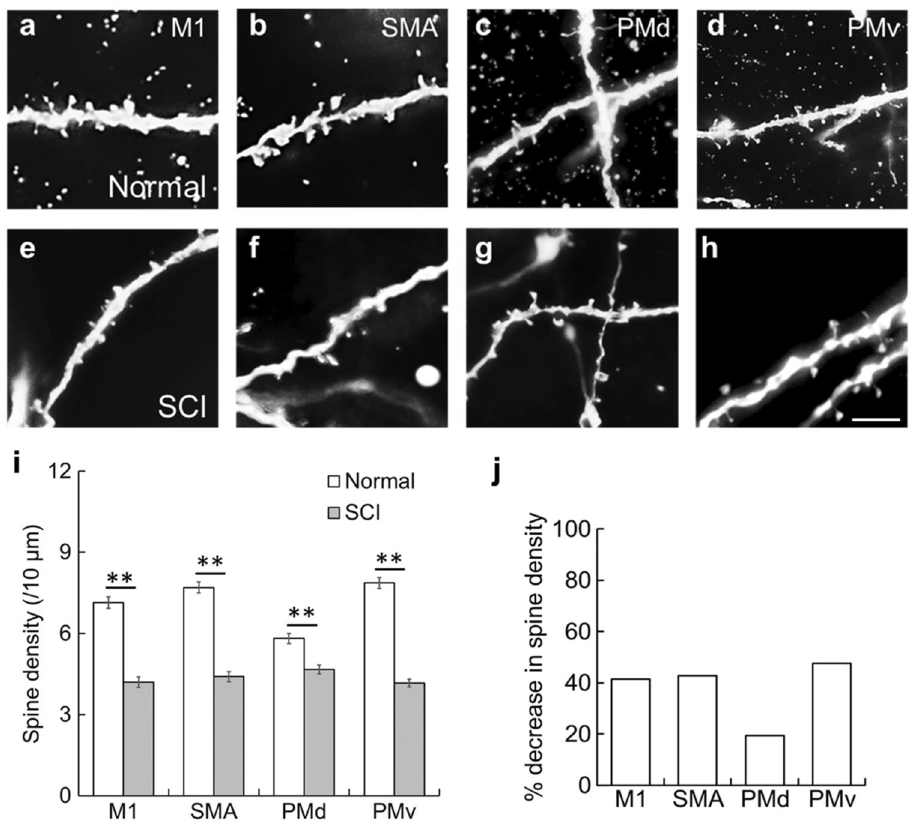
Figure 5. Decreased spine density post-SCI of basal dendrites of large layer V pyramidal neurons in frontal motor-related areas. ( a – h ) Representative morphology of spines on basal dendrite(s) of large layer V pyramidal neurons in the M1 ( a , e ), SMA ( b , f ), PMd ( c , g ), and PMv ( d , h ) in a normal control ( a – d ) and an SCI model ( e – h ). Scale bar, 4 µm. ( i ) Histogram showing the spine density of basal dendrites in the normal control (in white) and SCI model (in gray). Expressed as the number of spines per 10-µm segment of single representative dendrites (n = 20). Error bars denote SEM. Two-way ANOVA with the Bonferroni post hoc test. ** p < 0.01. ( j ) Histogram showing the decrease ratios of spine density after